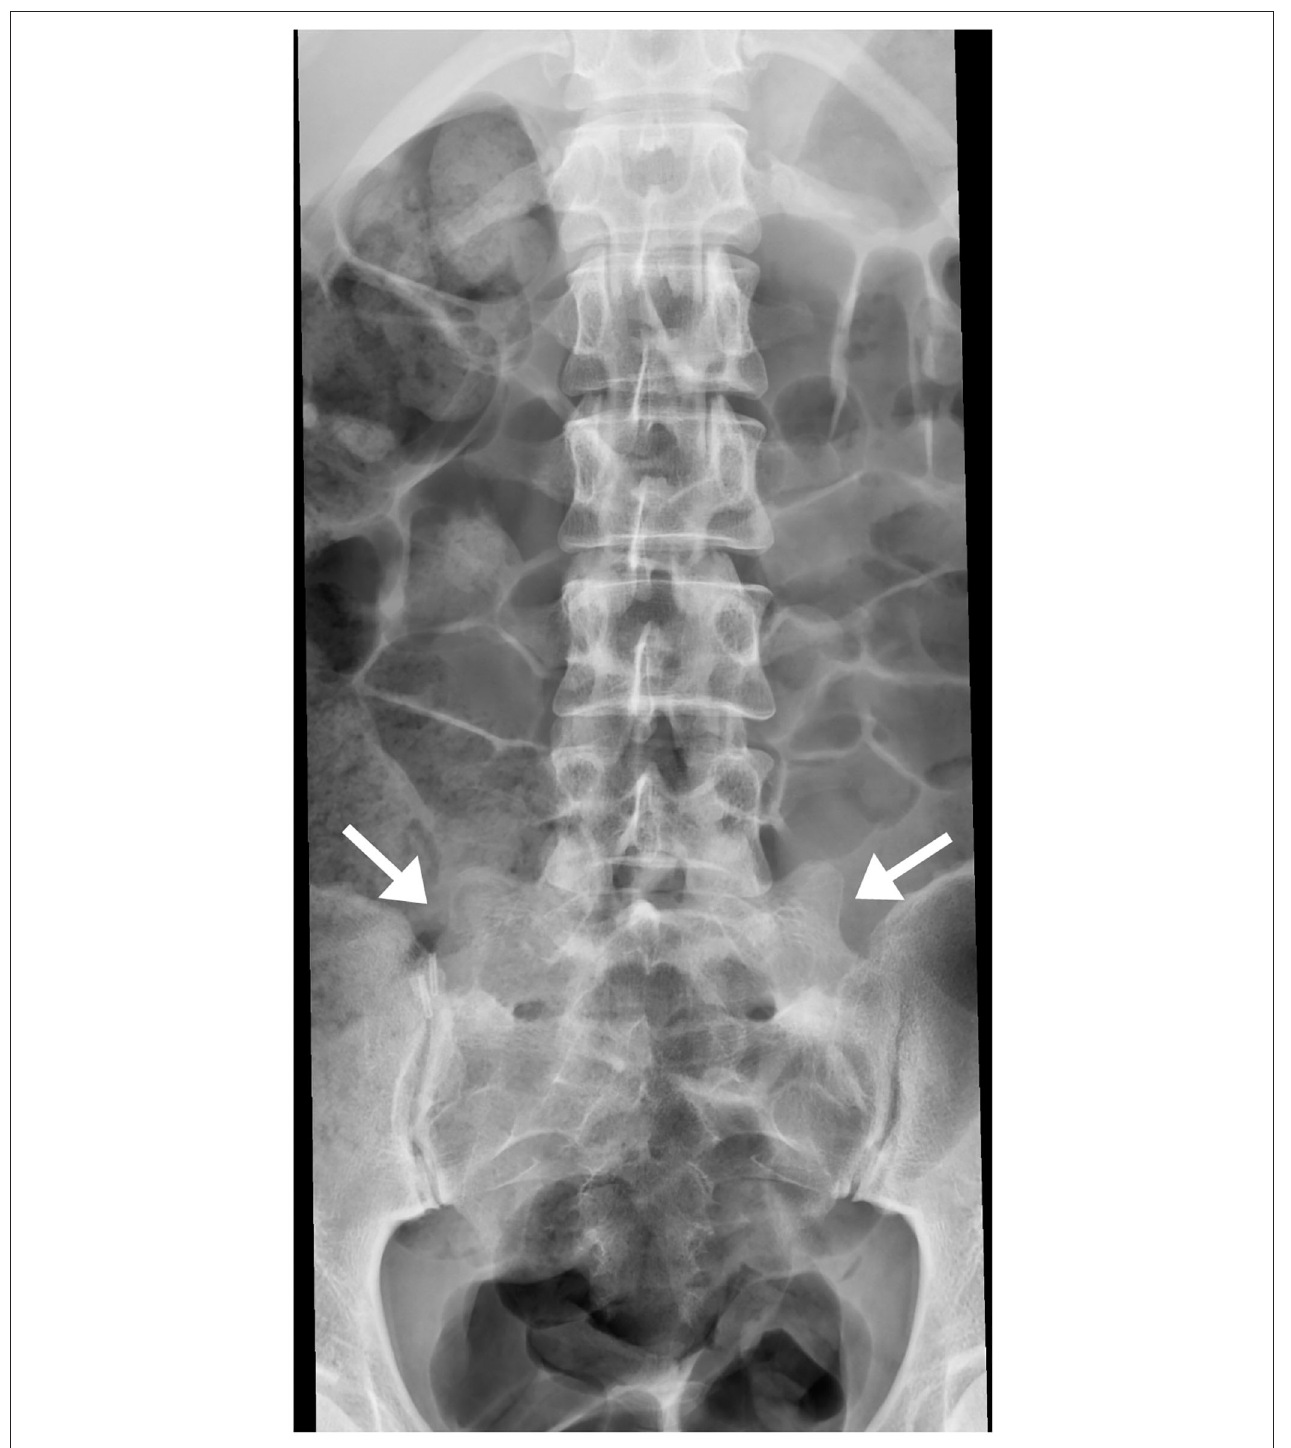
FIGURE 4 | Bilateral transitional vertebra (sacralization of L5), with neo-articulation of both hypertrophic transverse apophyses with the sacrum (arrows).